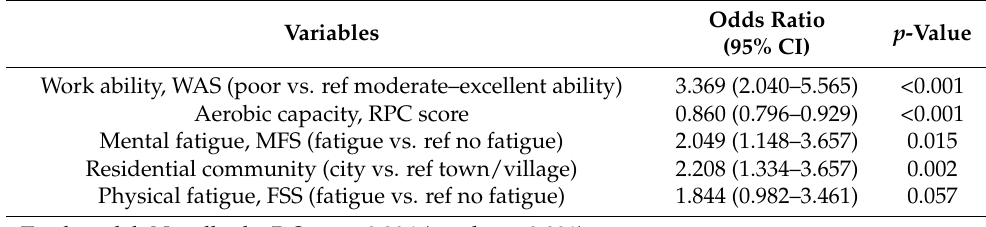
Table 5. Multivariate logistic regression analyses of factors associated with low satisfaction with Life as a whole in persons with post-COVID-19 ( n = 619). Variables